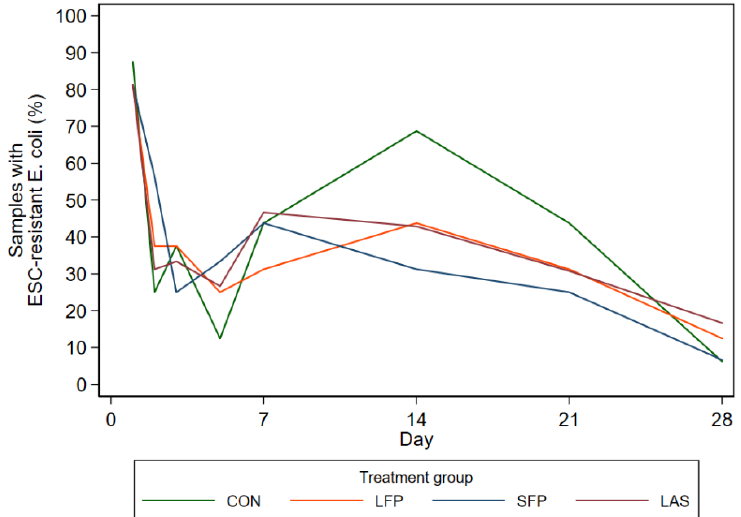
Figure 4. Percentage of pigs harbouring ESC-resistant E. coli over duration of the study and belonging to different dietary treatment groups. Treatment abbreviations: CON = control diet, LFP = CON + 2000 ppm Lactobacillus acidophilus fermentation product (LFP), SFP = CON + 2000 ppm Saccharomyces cerevisiae fermentation product (SFP), LAS = CON + 2000 ppm LFP + 2000 ppm